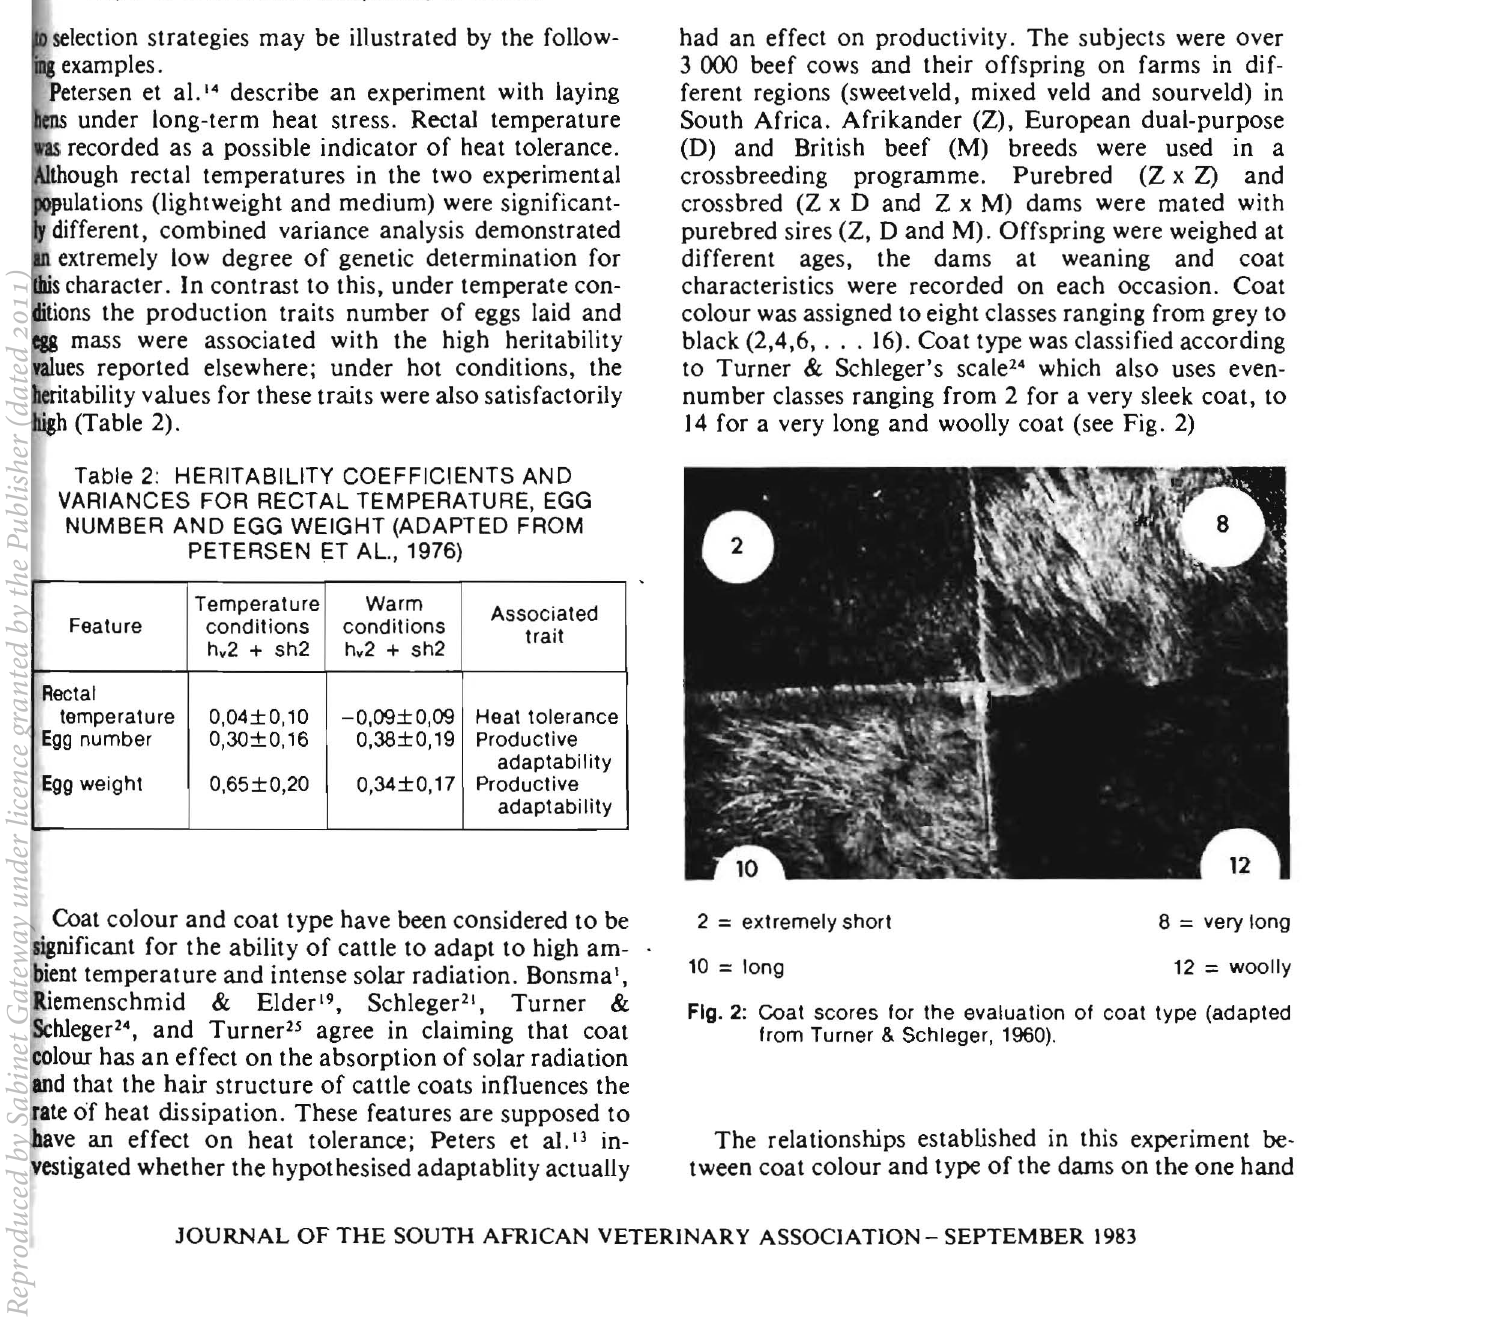
Fig. 2: Coat scores for the evaluation of coat type (adapted from Turner & Schleger, 1960).